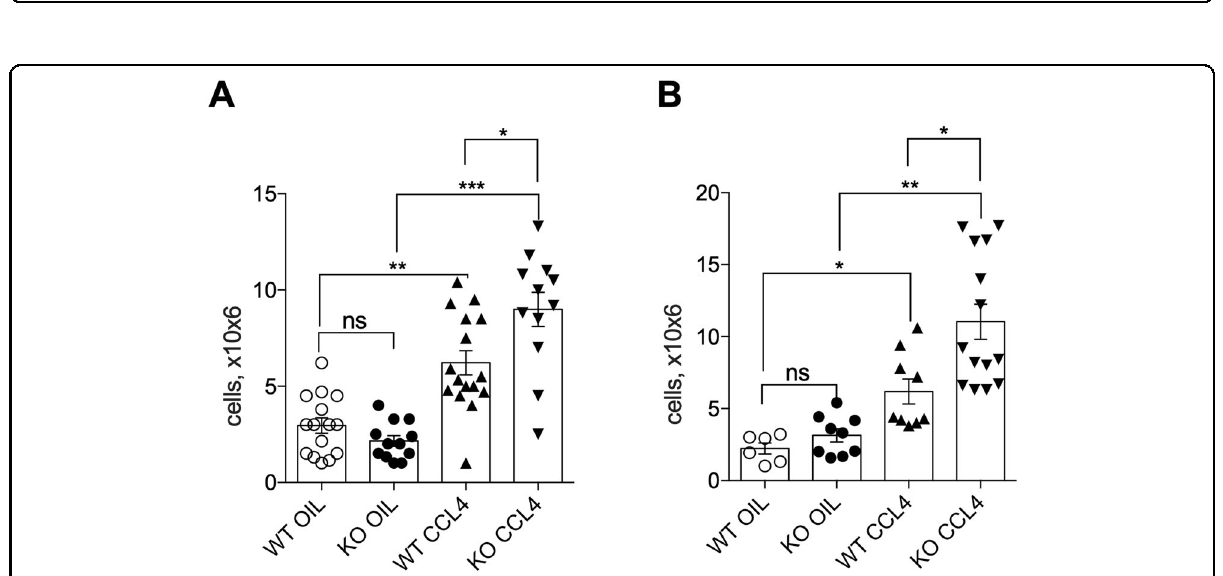
Fig. 3 Lack of GILZ results in increased leukocyte in fi ltration in the liver upon CCl 4 treatment. A , B Number of in fi ltrated leukocytes in livers from 4-month-old WT and GILZ KO mice that had been treated with oil (control) or CCl 4 for 72 h ( A ) and 6 – 7 weeks ( B ). Results are presented as the means ± SEM. Each dot represents an individual mouse; bars indicate the mean. Data were pooled from fi ve ( A ) or three ( B ) independent experiments (* p < 0.05, ** p < 0.005, *** p < 0.001, **** p < 0.0001, ns not signi fi